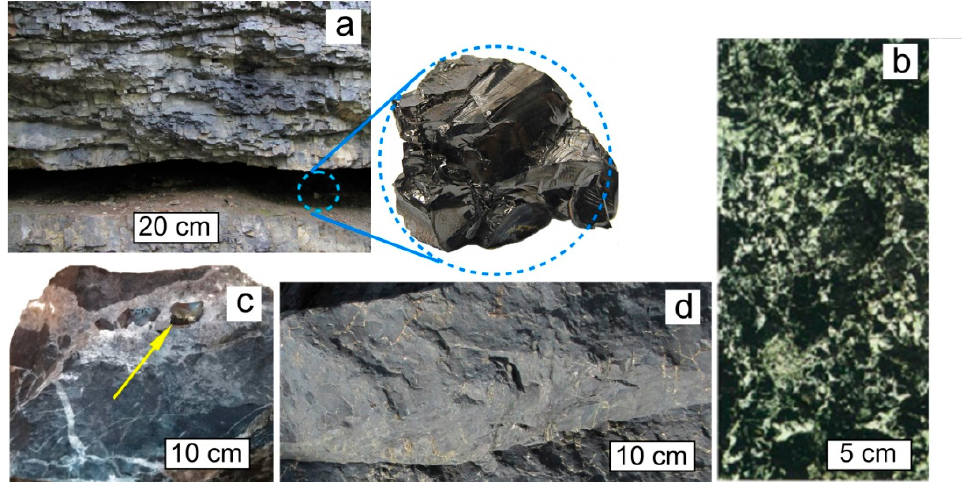
Figure 2. Typical occurrences of natural D sp 2 C: shungite carbon vein (Shunga occurrence, Karelia), with a typical sample in the inset ( a ). Cluster form of inclusions of D sp 2 C in the rock, Zazhogino occurrence, Karelia ( b ). D sp 2 C isolations as grains (indicated by yellow arrow) in a calcite vein, occurrence Rucheynoye, Kozhim River, Subpolar Urals, Russia ( c ). Rock (quartzite) impregnated with D sp 2 C, Maksovo occurrence, Karelia ( d ).